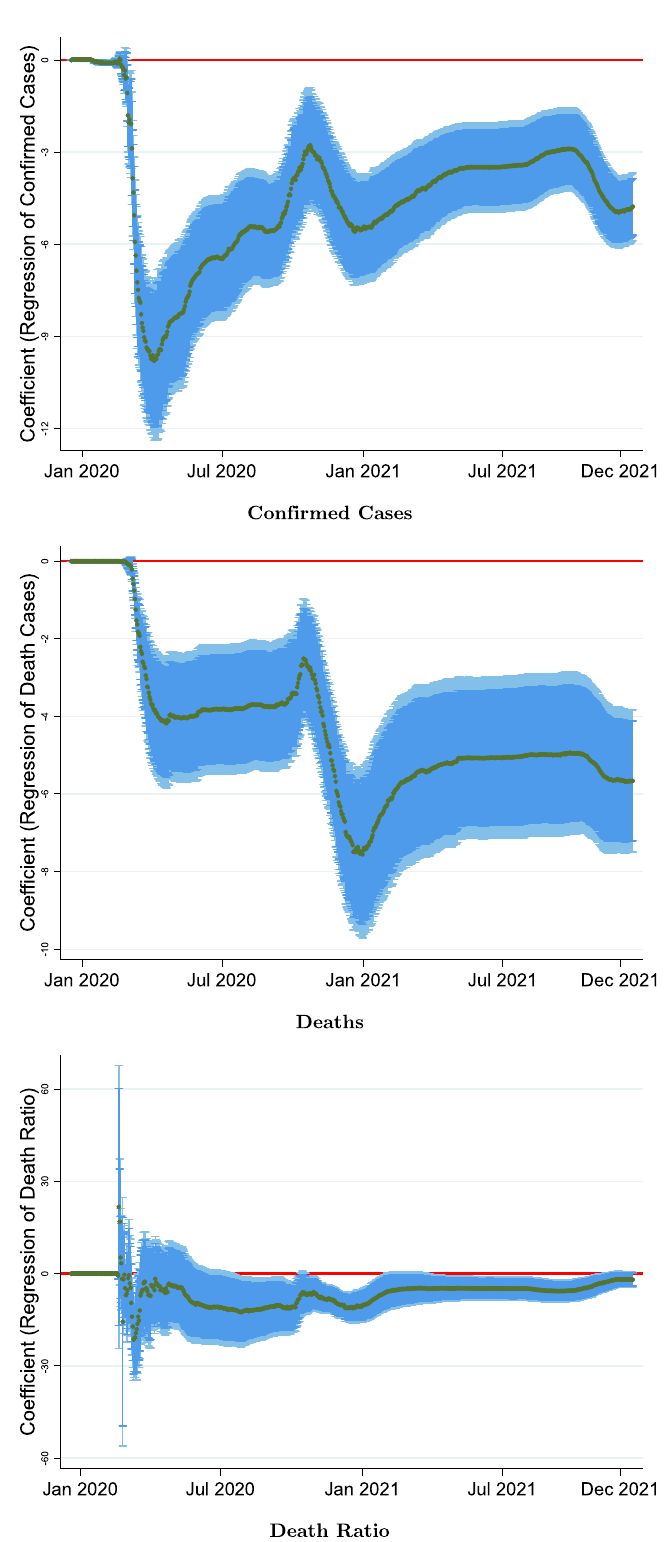
Fig. 7 Regression coef fi cients of COVID-19 variables on East for German districts, with controls. Daily regression coef fi cients (95 and 90% con fi dence interval) of con fi rmed cases, deaths and death ratio on East for all German districts (Berlin excluded), controlling for vaccination, relative days and district characteristics, 2020 and